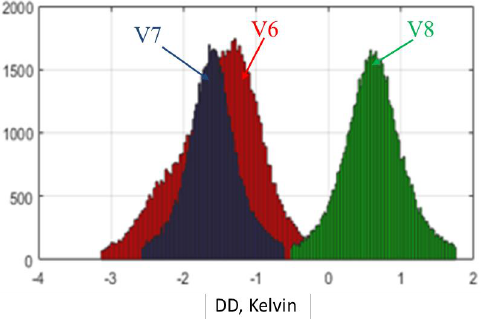
Figure 10. Double Differences (DD) distribution of channel 10.65 V for 1B11 V6 ( red ), V7 ( blue ) and V8 ( green ).